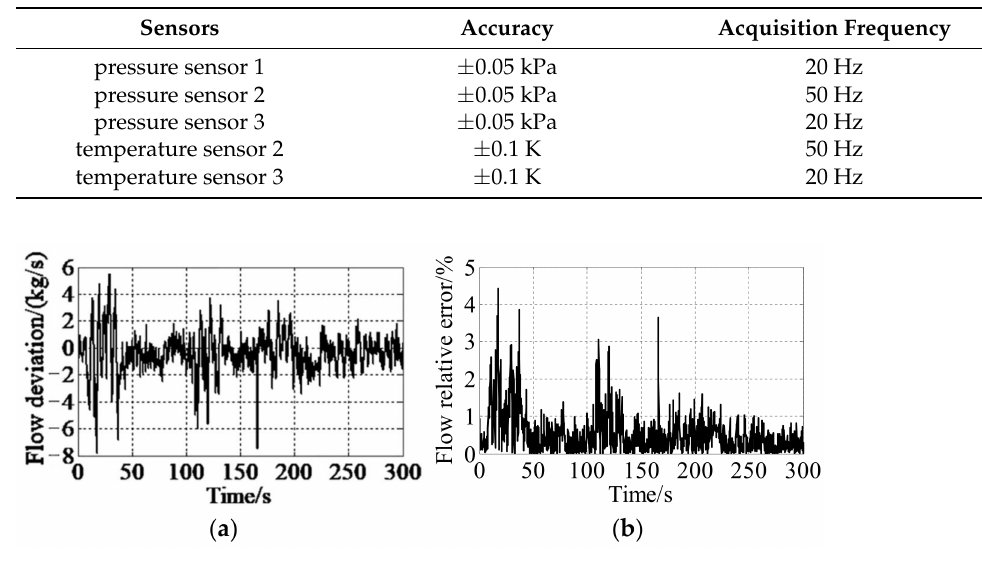
Table 1. Accuracy and sampling rate of sensors.